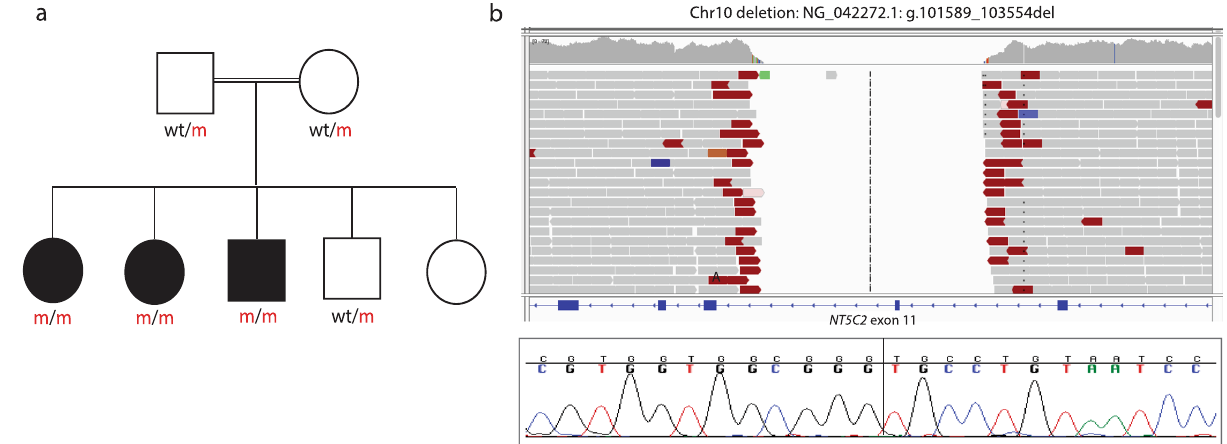
Fig. 1 a Pedigree structure of a family presenting with complex HSP due to a pathogenic NT5C2 mutation. Homozygous mutation carriers are represented as m/m and heterozygous carriers as wt/m. Dark squares (males) and circles (females) indicate HSP. b WGS reads of an affected